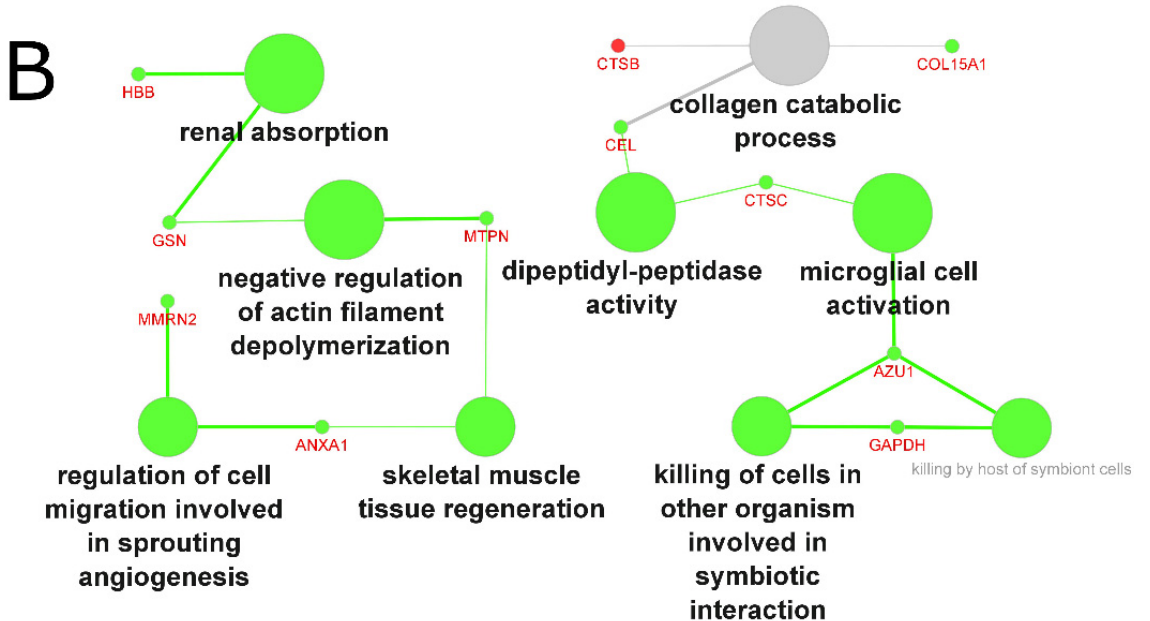
Figure 6. GO analysis of biological processes in muscle wasting-related atrophy, based on grouped molecules identified in ( A ) tissue samples and ( B ) biofluid samples from 24 proteomics studies. Green nodes represent downregulated processes, grey nodes represent common (shared) up- and downregulated processes; font and node sizes reflect statistical significance (kappa score = 0.4 and p -value < 0.01).